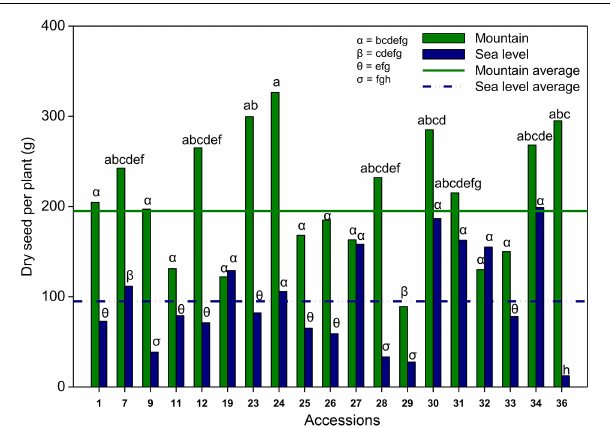
FIGURE 4 | Average seed production per plant of each climbing accessions in the mountain (black bars) and at the sea level (gray bars), and average seed production in the mountain (solid line) and at the sea level (dash-dotted line). Different letters indicate a significant difference between compared groups. α =